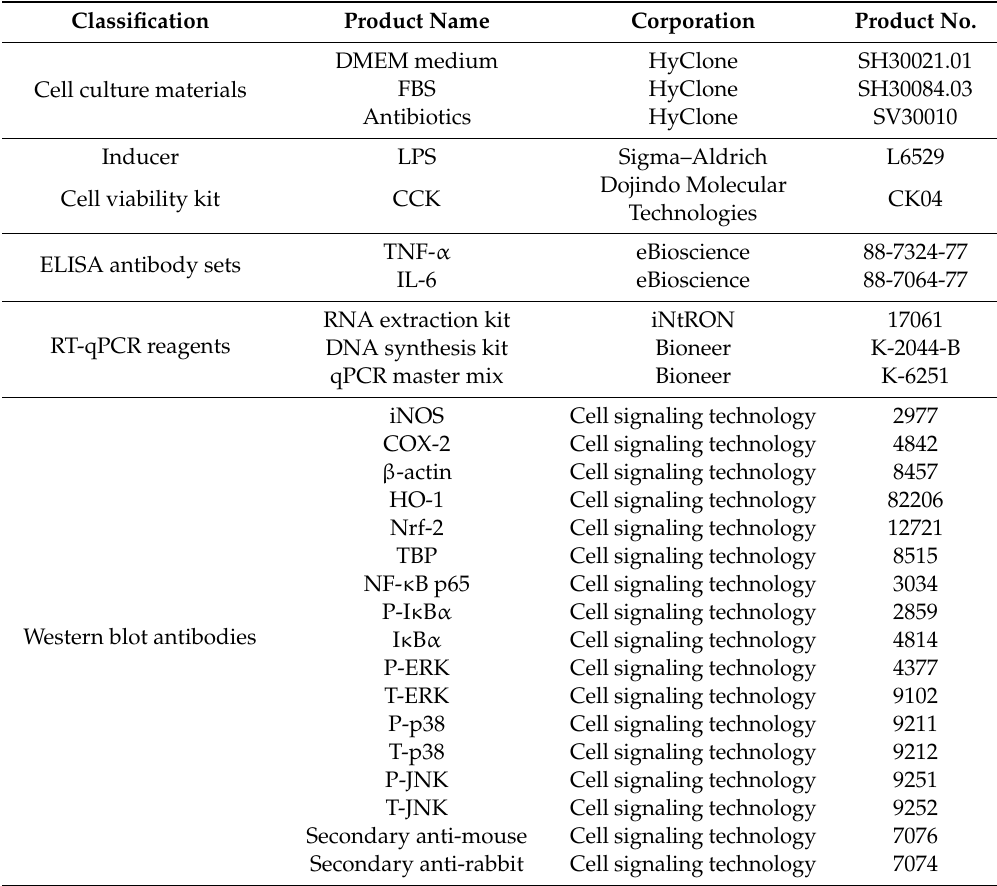
Table 2. Reagents, kits, and antibodies used in this